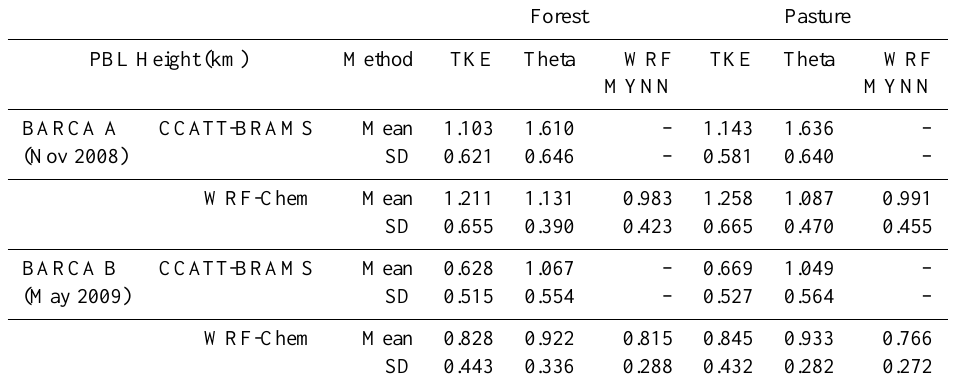
Table 4. PBL height at 21:00UTC (17:00LT) estimated from CCATT-BRAMS and WRF-Chem using methods based on turbulent kinetic energy (TKE) and theta ( θ) and the diagnostic from the WRF MYNN PBL scheme. Forest Pasture PBL Height (km) Method TKE Theta WRF TKE Theta WRF MYNN MYNN BARCA A CCATT-BRAMS Mean 1.103 1.610 (Nov 2008) SD Mean BARCA B CCATT-BRAMS